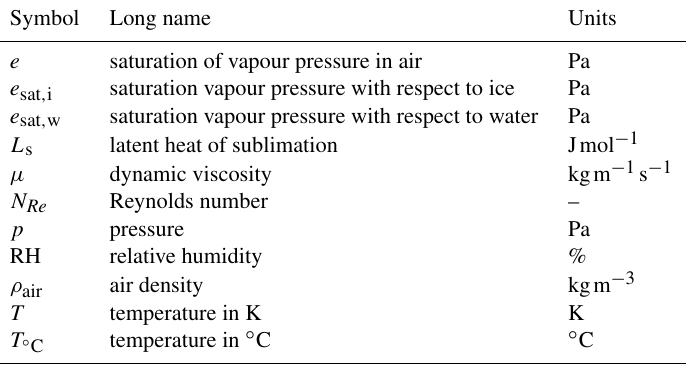
Table A1. Variables used in the sublimation height calculation (addition to Table 1).